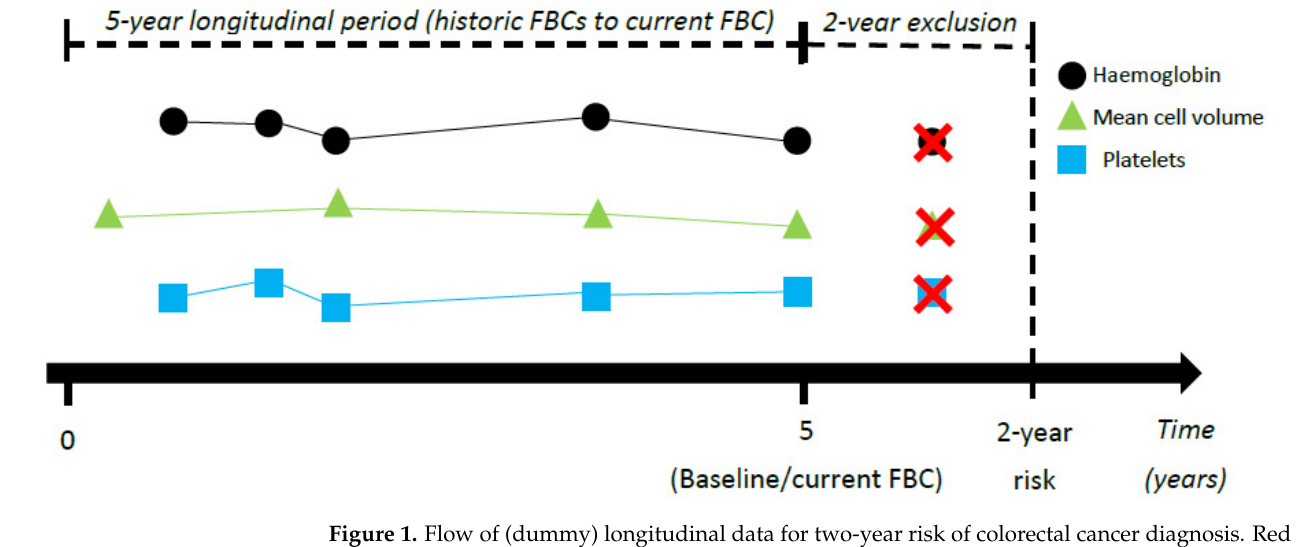
Figure 1. Flow of (dummy) longitudinal data for two-year risk of colorectal cancer diagnosis. Red X indicates tests that were excluded.